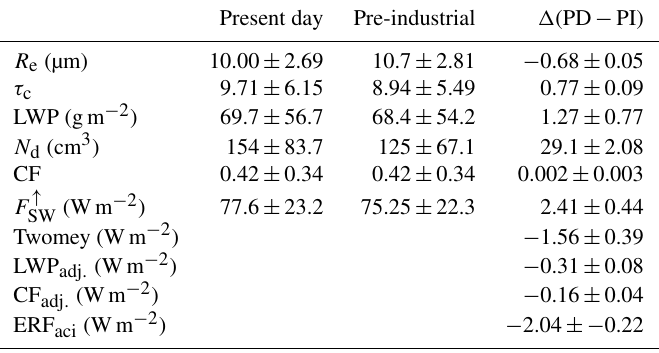
Table 8. List of cloud and radiative effects from aerosol perturbations based on present-day values relative to pre-industrial aerosol simula- tions. ERF aci estimates are provided separately for the decomposition by Twomey, LWP adj , and CF adj , in addition to those computed using the method described in Ghan